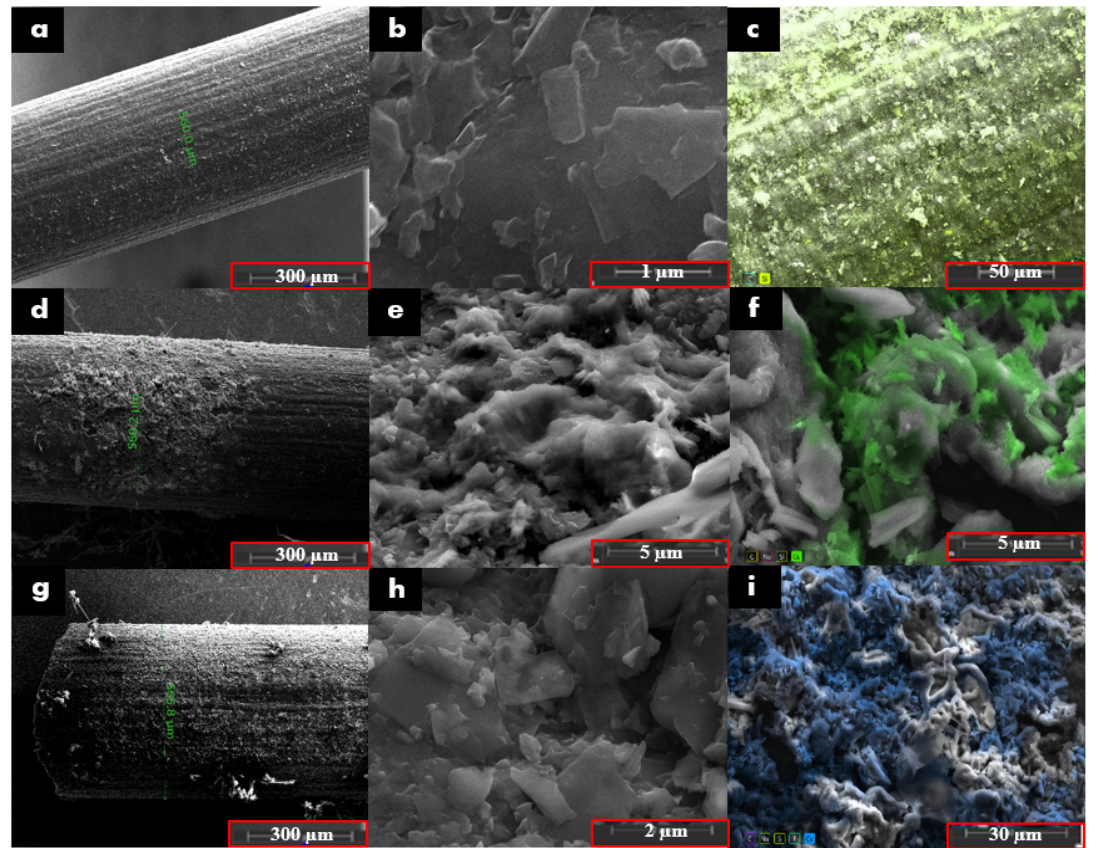
Figure 2. SEM images of ( a ) unmodified PGE at 300× and ( b ) 80,000×, EDX image of ( c ) PGE at 1300×. SEM images of ( d ) HAP-modified PGE at 300× and ( e ) at 20,000×. EDX image of ( f ) HAP-modified PGE at 12,000×. SEM images of ( g ) HAP- and copper-oxide-modified PGE at 300× and ( h ) at 400×. EDX image of ( i ) HAP- and copper-oxide-modified-PGE at 3000×.